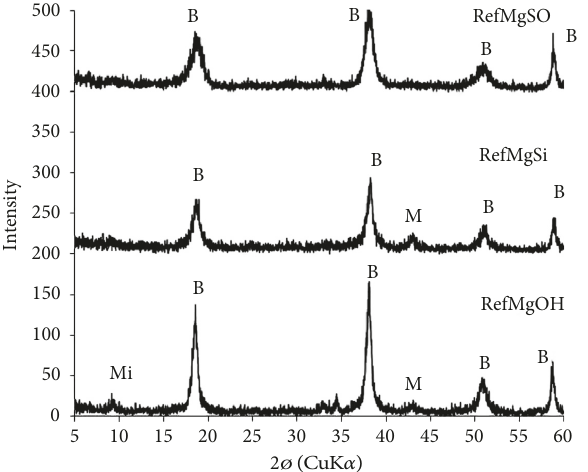
Figure 3: XRD spectra of magnesia mixes alkali activated with sodium hydroxide, sodium silicate, and sodium sulphate. B: bru- cide, M: magnesia, and Mi: mika.